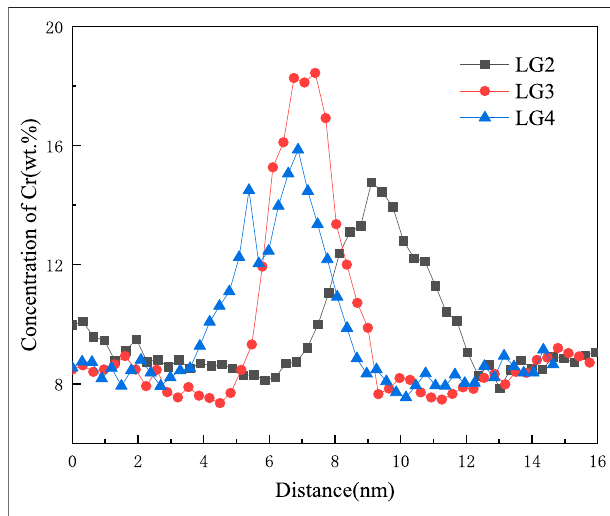
FIGURE 10 | Concentration pro fi les of Cr at the bubble-loop complexes obtained by EDS analysis.